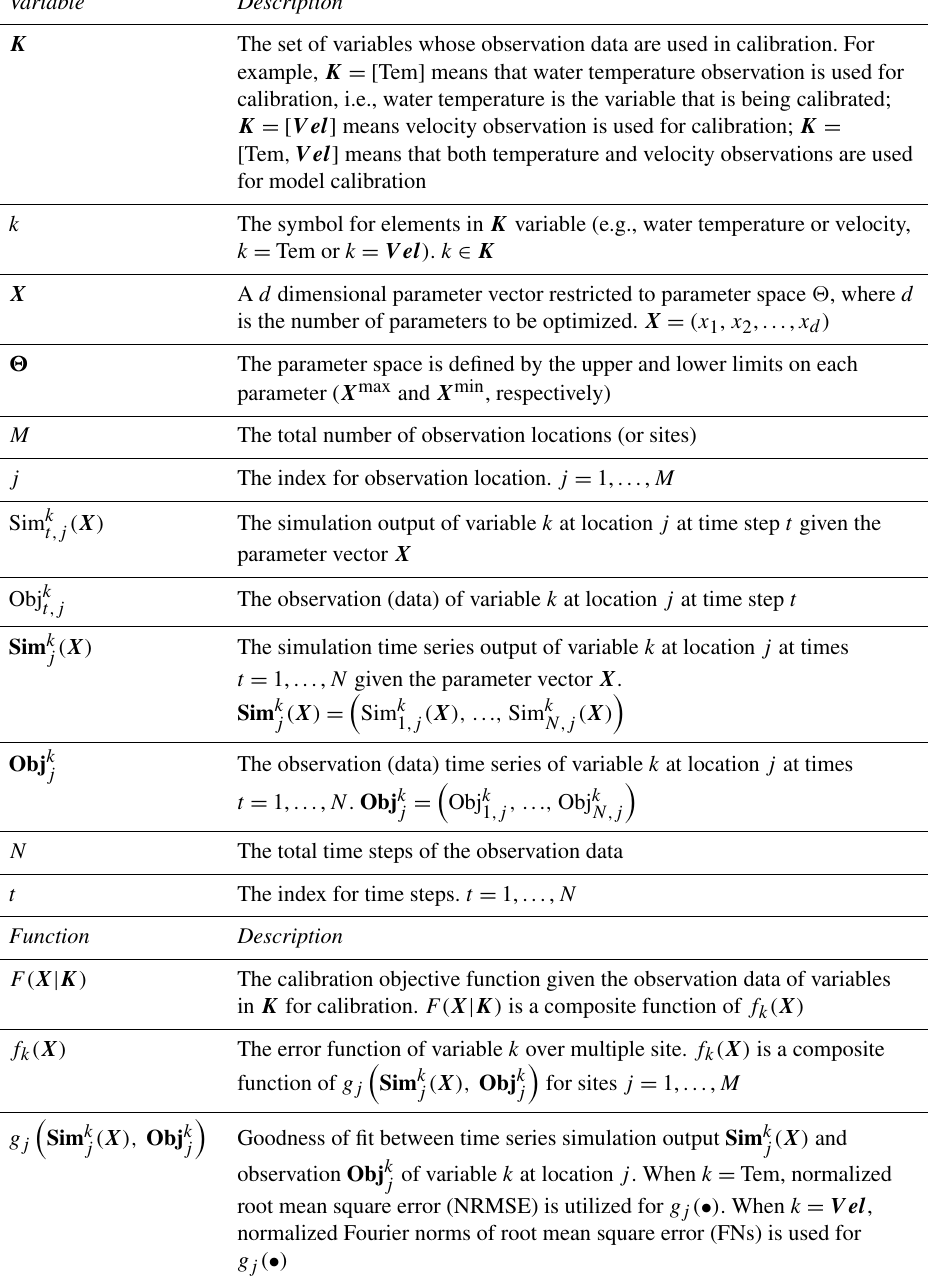
Table 1. Notation and definitions of variables and functions in Eqs. (1) and (2). Variable